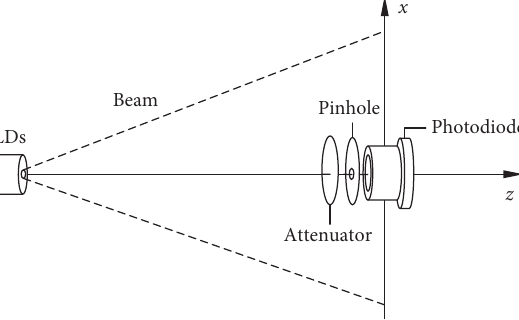
Figure 2: Experimental setup.